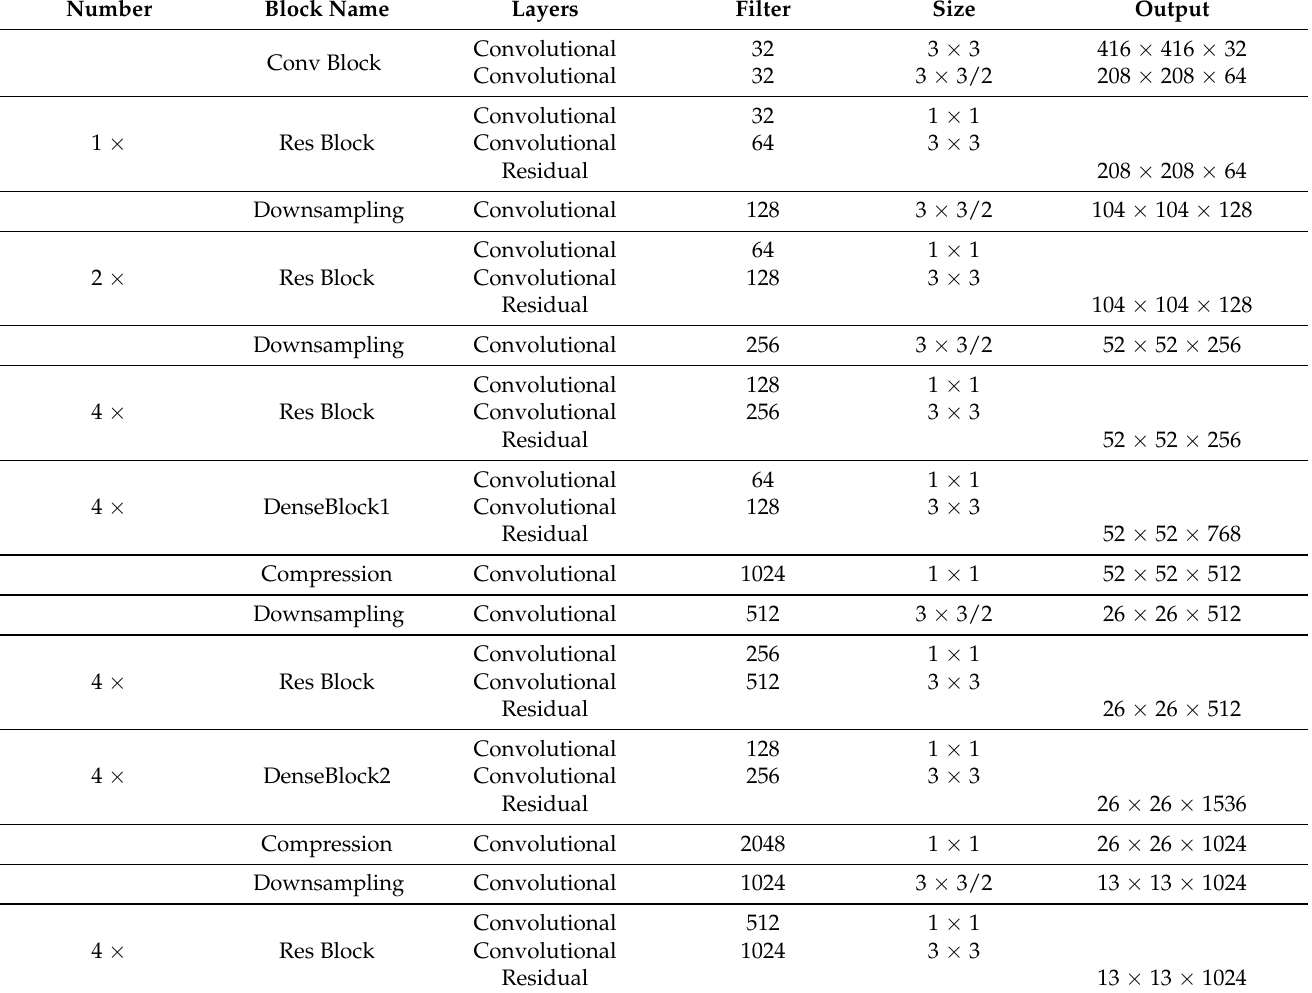
Table 2. Parameters of the DR-Net feature extraction